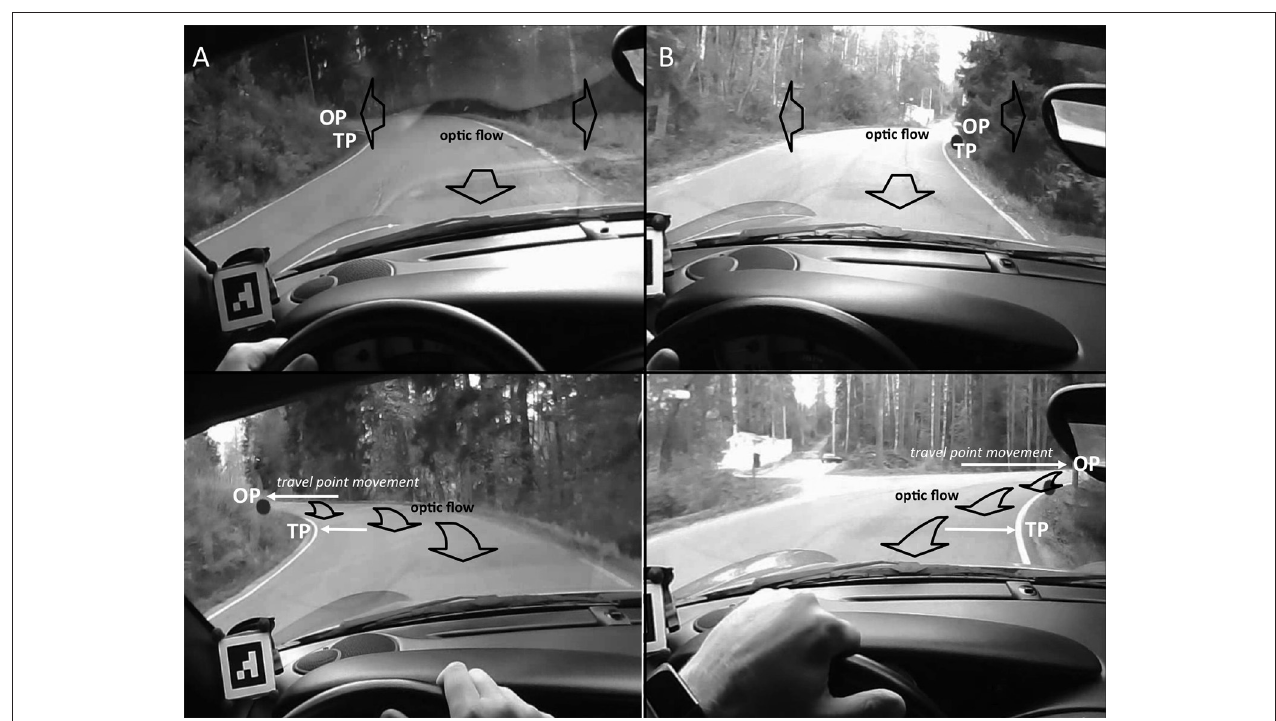
FIGURE 3 | Schematic illustration of how a bend “opens up” as the Occlusion Point travels up the road (and horizontally in the visual field), revealing more of the road. (A) Left hand bend. Top panel: approaching. Bottom panel: turning in. (B) Right hand bend. Top panel: approaching. Bottom panel: turning in. The Occlusion Point (like the tangent point) is a travel point , not a fixed 3D location in the scene. Travel point motion in the visual field (indicated by the white arrows) does not match the optic flow (indicated by the black block arrows). Fixating a travel point may be a tracking fixation, achieved with a pursuit movement. The same is clearly true also for tracking stationary fixed 3D scene objects or locations, but here the tracking will match optic flow. OP, Occlusion Point; TP, Tangent